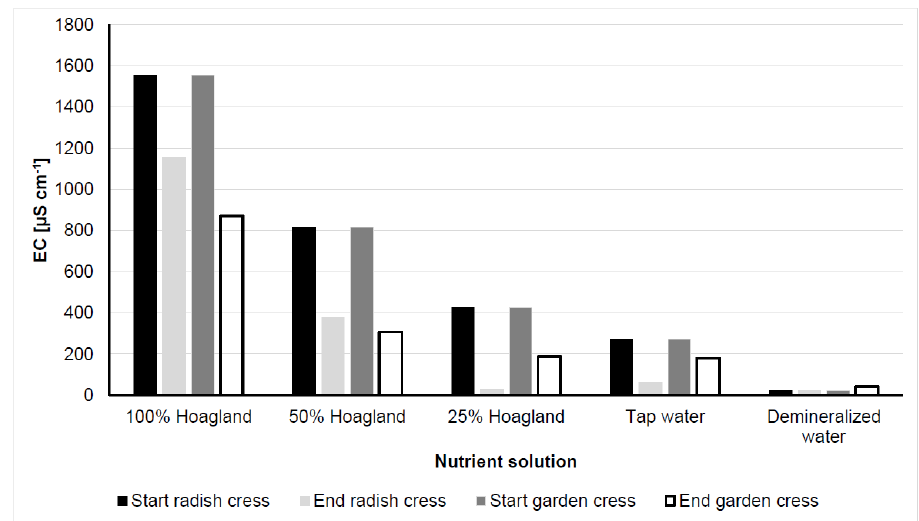
Figure 5. Average electrical conductivity (EC) of the nutrient solution of two measurements at the beginning of cultivation and at harvest of the microgreens, radish and garden cress.